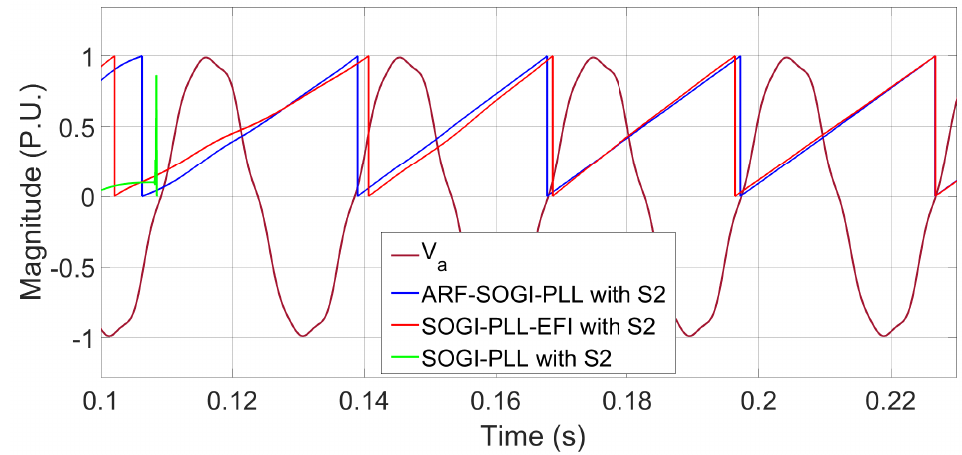
Figure 13. ω t measured during − 6 Hz deviation to before 60 Hz